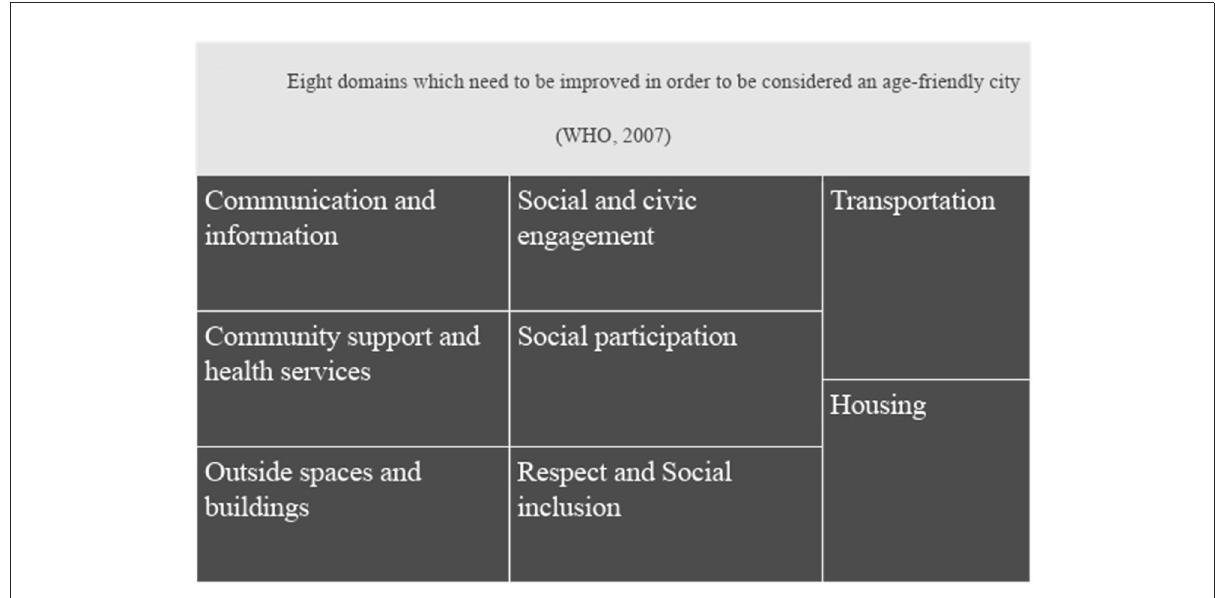
FIGURE1 The eight domains that need to be improved within a city to be considered an age-friendly city (WHO,